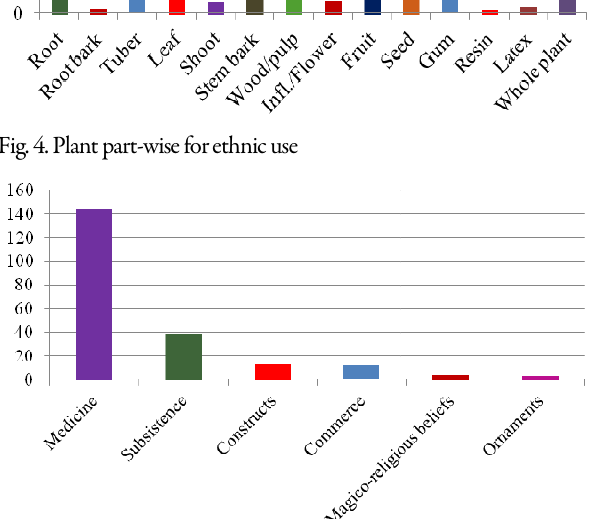
1 Fig. 5. Ethnic-use pattern and proportions in Pocharam wildlife use pattern and proportions in Pocharam sanctuary